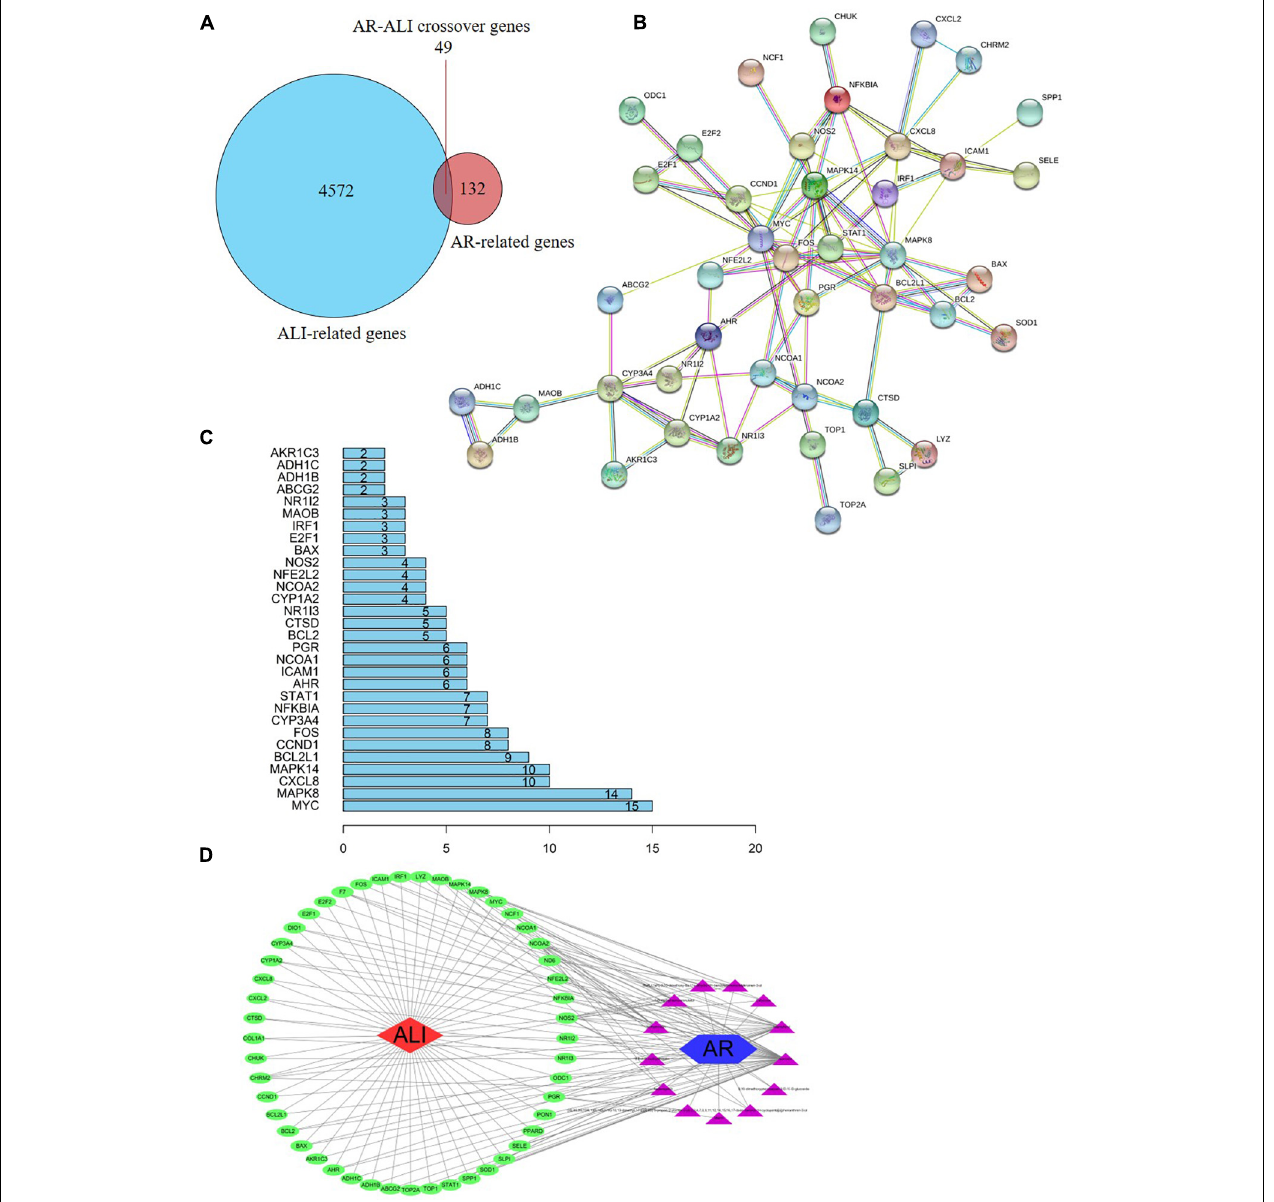
FIGURE 4 | Network analysis of targets. (A) Venn diagram of AR- and ALI-related proteins. The overlapped genes were considered as the potential hub genes of AR against ALI. (B) Cluster analysis of the PPI network. 49 AR-ALI crossover proteins were filtered into the PPI network complex. (C) Histogram of key proteins. The y-axis represents the name of genes, the x-axis represents the number of adjacent genes, and height is the number of gene connections. (D) The Component-Target protein network. The triangles represent the 13 candidate active compounds in AR. The green circles represent the gene names of target proteins of ALI found by screening from GEO and online database. ALI, acute liver injury; AR, astragali radix; PPI, protein–protein interaction; GEO, Gene Expression